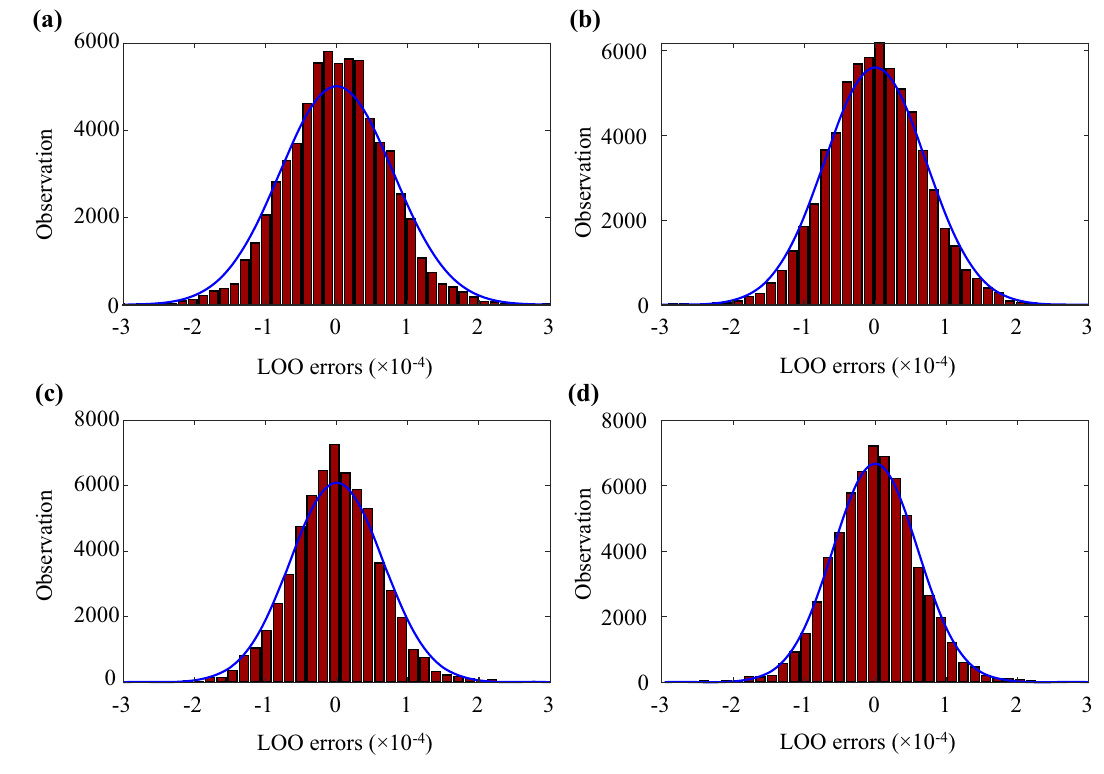
Fig. 17 Histograms of LOO errors: a lateral-left; b lateral-right; c vertical-left; d